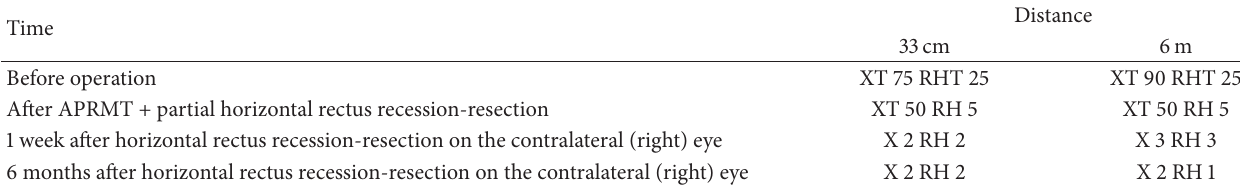
Table 3: Angles of strabismus of the unaffected eye in patient 10 before and after surgery.